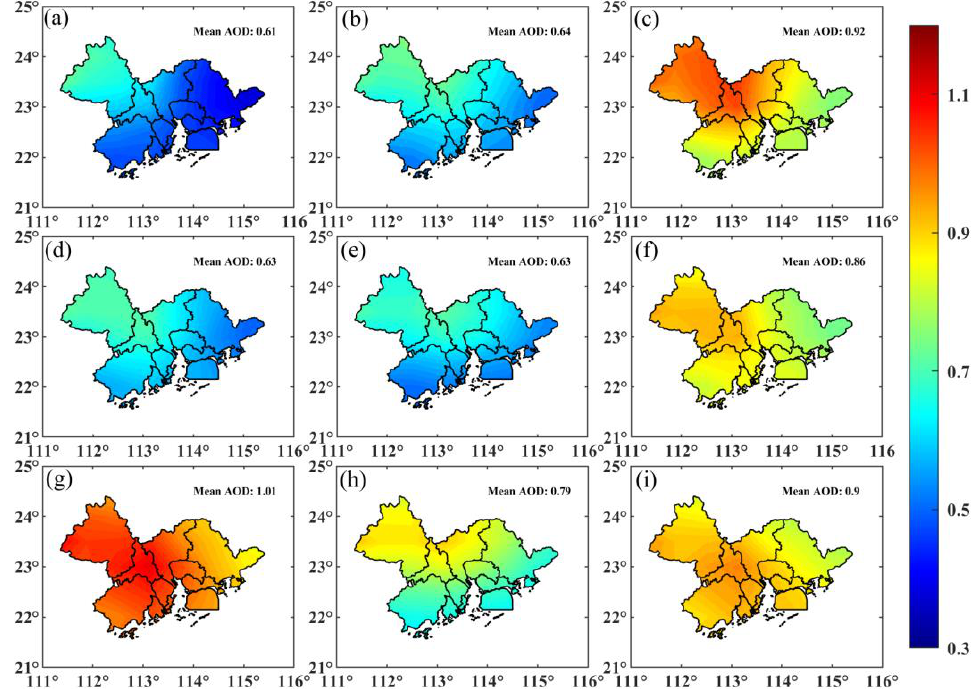
Figure 5. Spatial distribution of AOD under different stages and levels in February and March from 2012 to 2021. ( a – c ) Slight humidity, ( d – f ) moderate humidity, and ( g – i ) heavy humidity; ( a , d , g ) be- fore-stage, ( b , e , h ) wet-stage, and ( c , f , i ) after-stage.